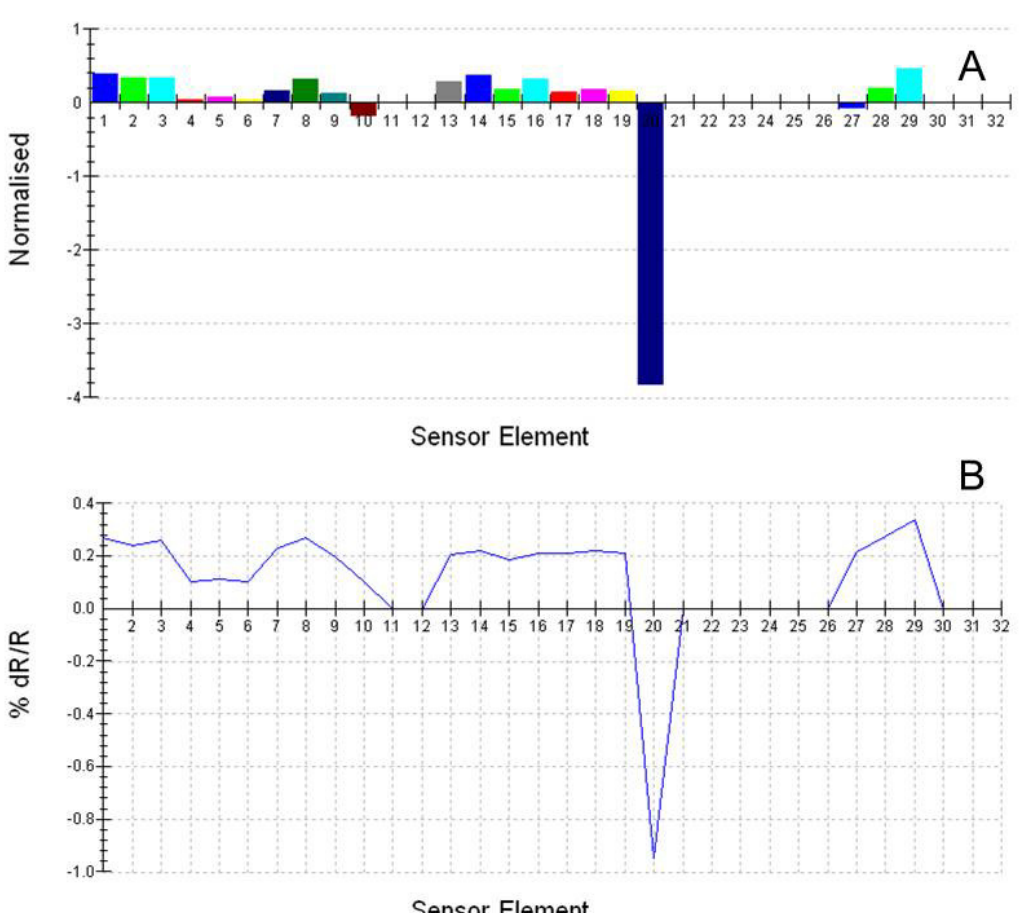
Figure 2. Aroma sensor responses of the A32S sensor array in difference mode. Sensor response percentage differences in e-nose sensor output intensities of individual numbered sensors are indicated for headspace volatiles of good-flavor minus off-flavor catfish meat samples presented as ( A ) bar graph (indicating differences in normalized sensor values) and ( B ) line-graph (indicating percent changes in sensor resistance responses relative to baseline resistance). Sensor element numbers represent individual numbered sensors in the e-nose sensor